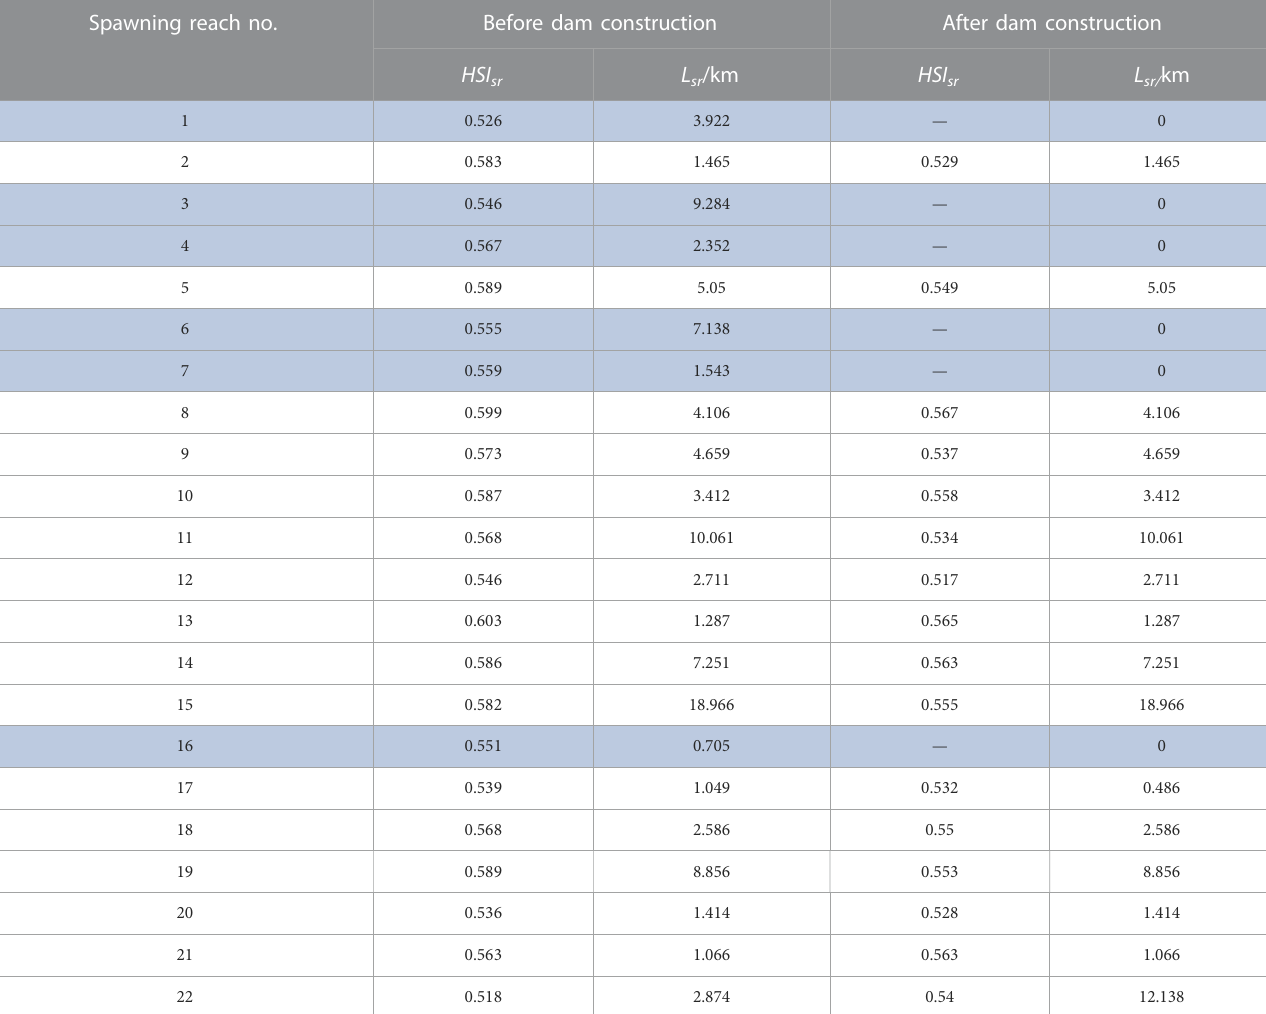
TABLE 6 Habitat suitability index of the spawning reach HSI sr and the size of spawning reaches L s r for the Yellow River carp, before and after the construction of the Xiaolangdi Dam. Spawning reach no.